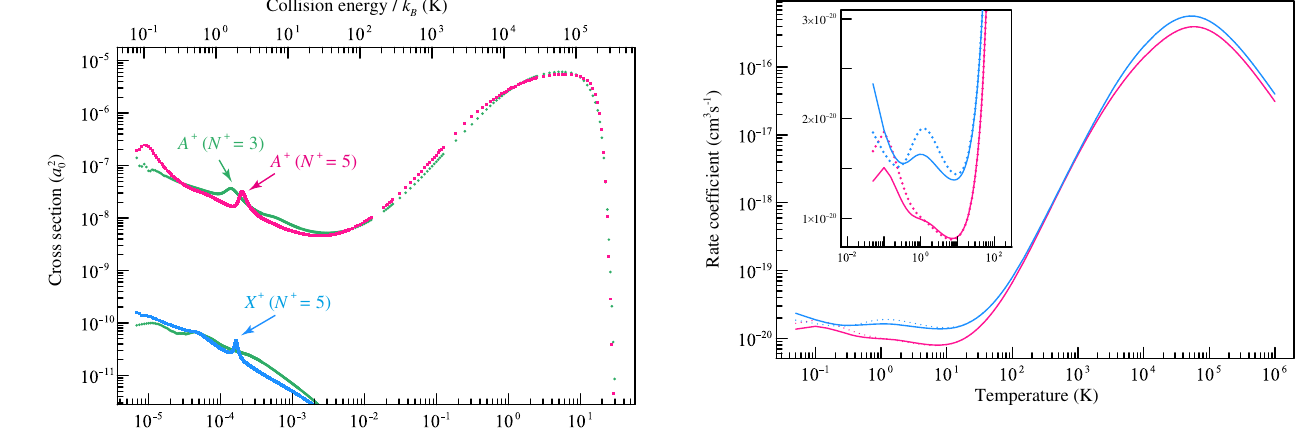
FIG. 9. Thermal rate coefficient for radiative association as a function of the temperature: D þ þ D ð 1 s Þ (red) and H þ þ H ð 1 s Þ (blue). The dotted lines correspond to calculations neglecting the restrictions imposed by the Pauli principle. The inset shows the curves at low temperatures on a linear